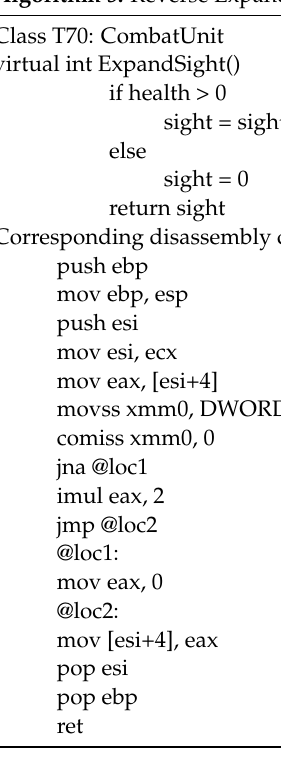
Algorithm 5: Reverse ExpandSight().